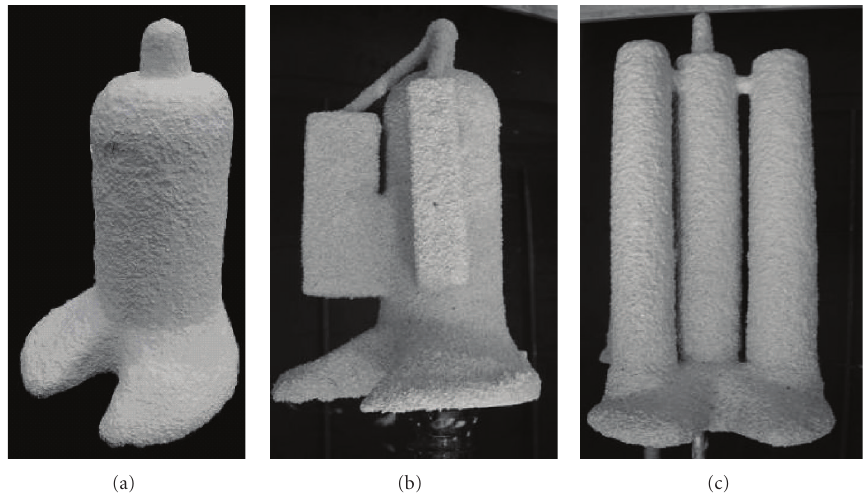
Figure 4: SM (a), ME (b) and BM (c).